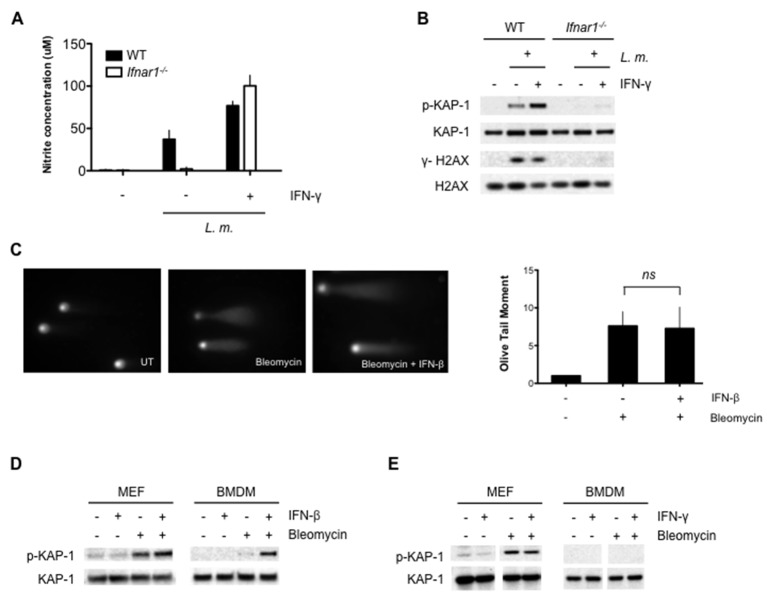
Optimal DDR depends on type I interferon signaling.(A) Nitrite concentration in culture supernatants collected from WT and Ifnar1-/- BMDMs after no infection (-) or infection (+) with L. m. for 24 hr. in the presence or absence of IFN-γ. Data are a compilation of three independent experiments and depict mean and SEM. (B) Western blotting for γ-H2AX, H2AX, p-KAP-1, and KAP-1 in whole cell lysates from WT and Ifnar1-/- BMDMs after no infection (-) or infection (+) with L. m. for 24 hr. in the presence or absence of IFN-γ . (C) Neutral Comet assay and Olive Tail Moment quantification of BMDMs left untreated (UT) or after treatment with bleomycin in the presence or absence of type I interferon (IFN-β). (D, E) Western blotting for p-KAP-1 and KAP-1 of WT mouse embryonic fibroblasts (MEFs) or BMDMs after no stimulation (-) or stimulation with bleomycin (1 ug/mL), (D) IFN-β (100 U/mL), or bleomycin + IFN-β for 6 hr. (E) IFN-γ (10 ng/mL), or bleomycin + IFN-γ for 6 hr. Data are representative of 2-4 independent experiments. Quantitation in (C) is the mean and SEM of three independent experiments where ≥50 tails were analyzed for each condition and Olive Tail Moment of treated is expressed as a ratio to untreated. ns = not significant. Blank space in (E) indicates that blot has been croppedDOI: